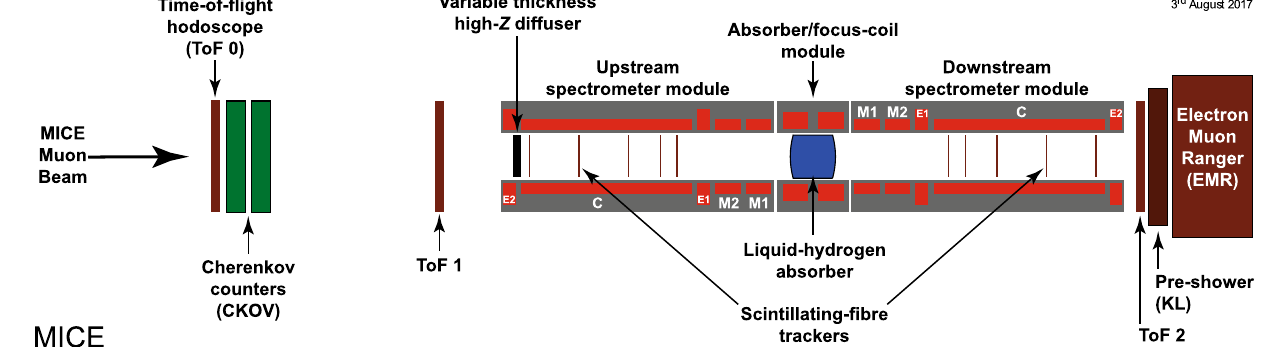
Fig. 1 SchematicdiagramoftheMICEexperiment.Theredrectangles represent the coils of the spectrometer solenoids and focus-coil mod- ule. The individual coils of the spectrometer solenoids are labelled E1, C, E2, M1 and M2. The various detectors (time-of-flight hodoscopes